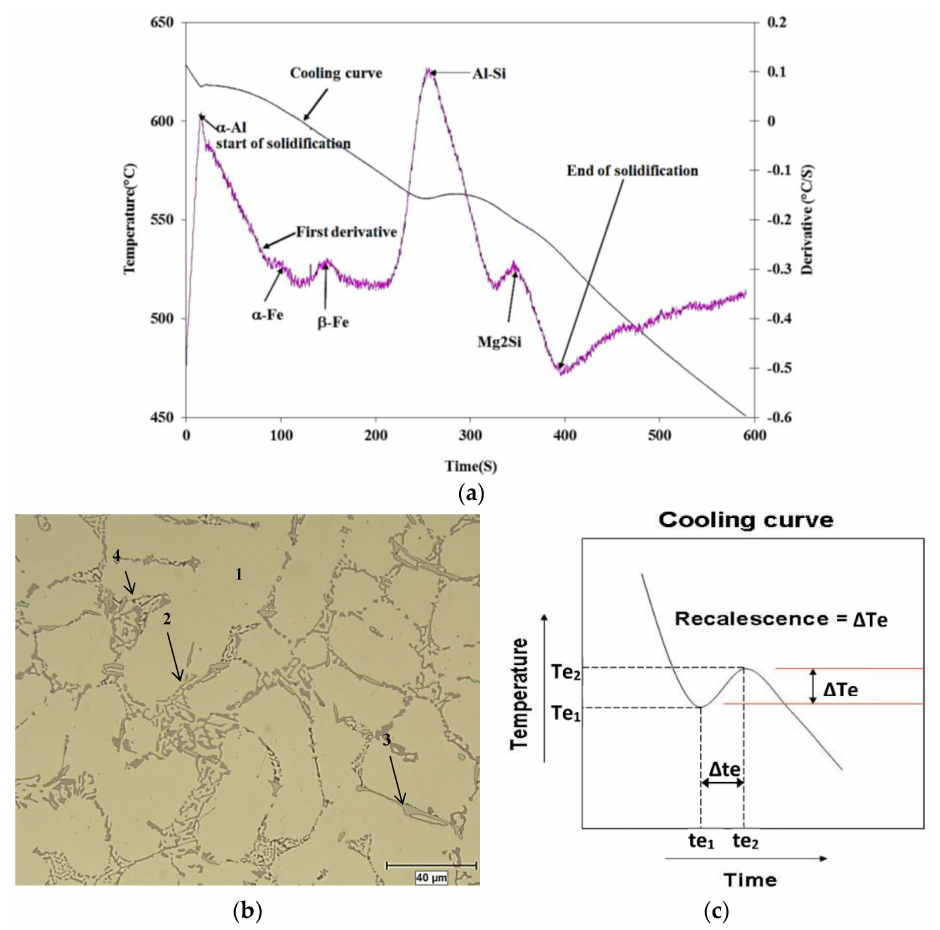
Figure 2. ( a ) Solidification curve and its first derivative of A356 alloy; ( b ) Optical microstructure of A356 alloy (coded TB) following solidification at the rate of ~0.8 ˝ C/s: 1— α -Al, 2—eutectic Si, 3—Fe-intermetallic, 4—Mg 2 Si phase; ( c ) Schematic diagram of a hypothetical cooling curve showing